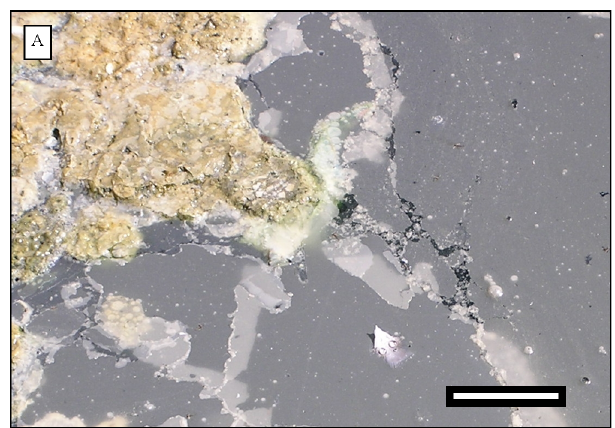
Figure 8. Marginally precipitating systems under high temperature. Living biofilm associated with superficial skins of calcite. Note the thin calcite rafts at the air–water interface. This is the only observ- able precipitate at the site. Scale bar is 100mm long. Recent, Petre- ole,